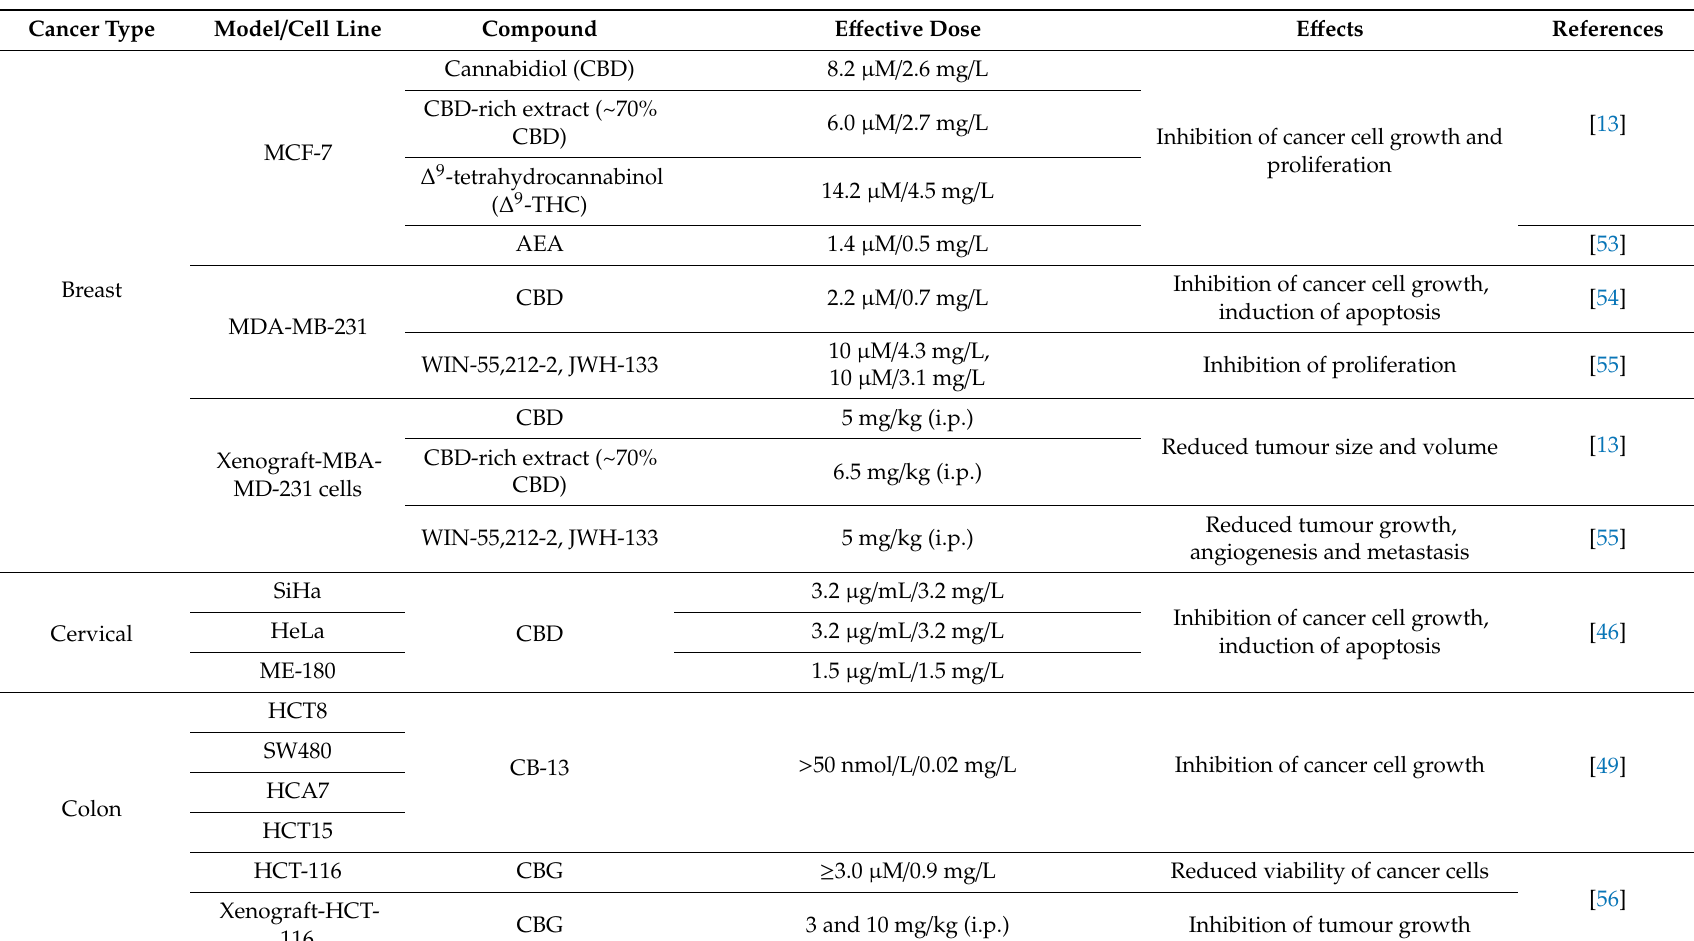
Table 1. Anti-cancer e ff ects of cannabinoids in various cancer cell